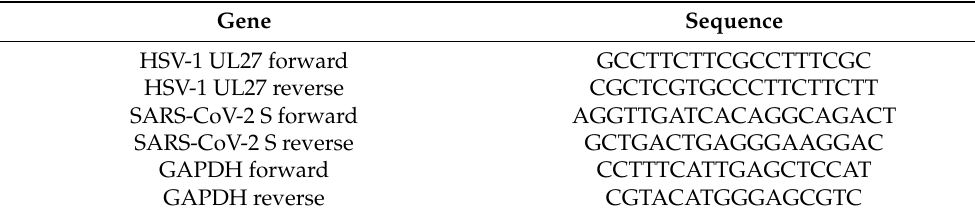
Table 1. Primers used in Real-Time